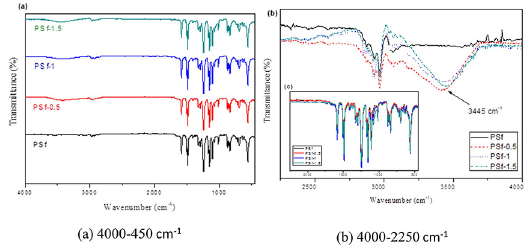
Figure 8: Cross-section SEM images of the prepared membranes (magnification ×500): (a) PSf, (b) PSf-0.5, (c) PSf-1 and (d) PSf-1.5.